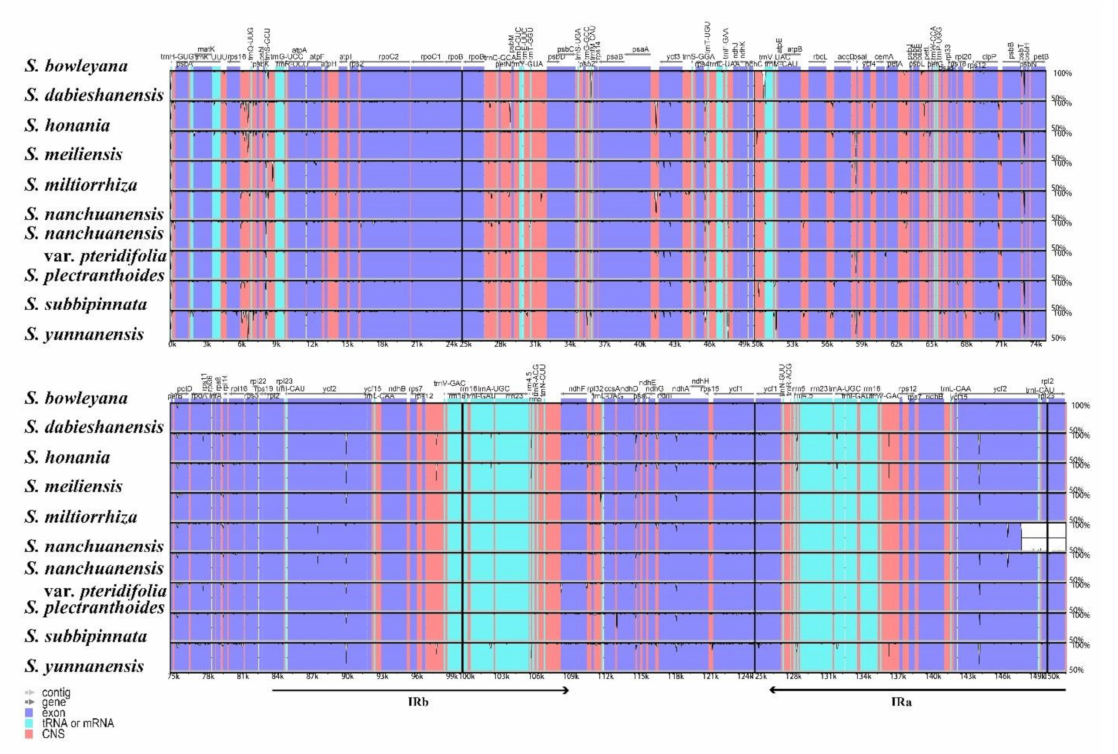
Figure 7. Sequence alignment of the whole plastomes of 10 taxa of Salvia sect. Drymosphace using mVISTA with S. bowleyana as a reference. The vertical scale indicates percentage of identity, ranging from 50% to